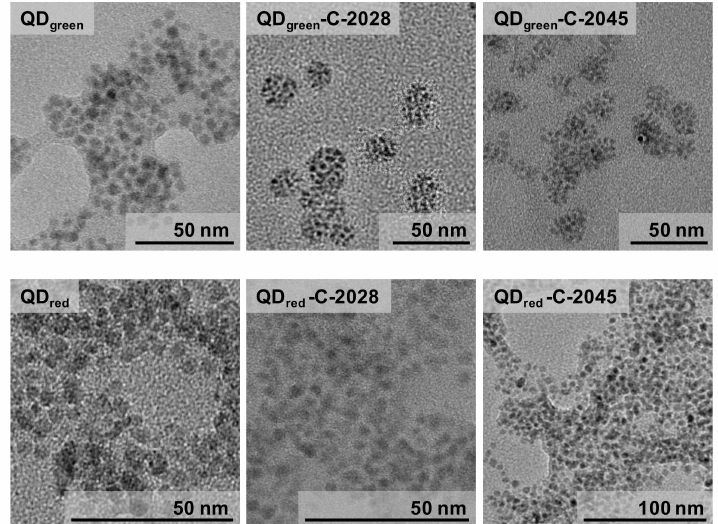
Figure 2. TEM images of QDs and their hybrids with UA